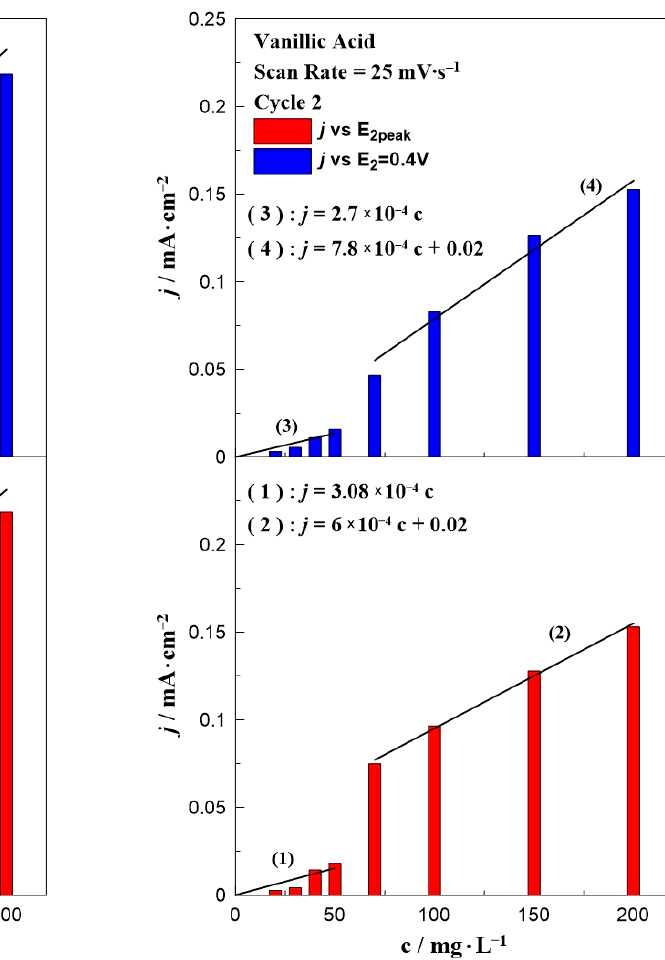
Figure 4. Effect of vanillic acid concentration on the current density value at E 1 and E 1, peak ( left ) and E 2 and E 2, peak ( right ) at a constant scan rate of 25 mV ∙ s − 1 .